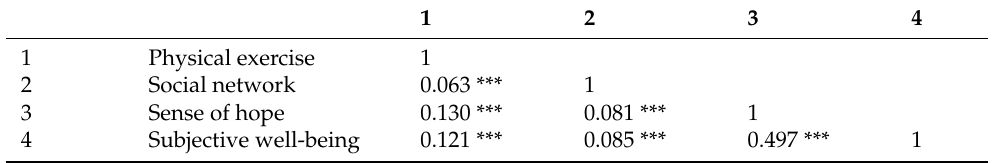
Table 3. Pearson correlation